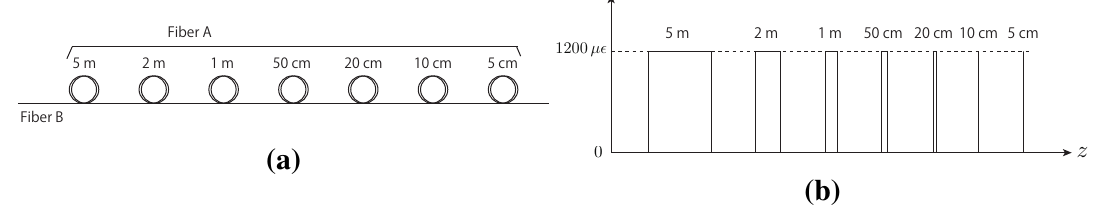
Figure 14. The fiber under testing used in experiment: ( a ) the fiber setup and ( b ) the equivalent strain.